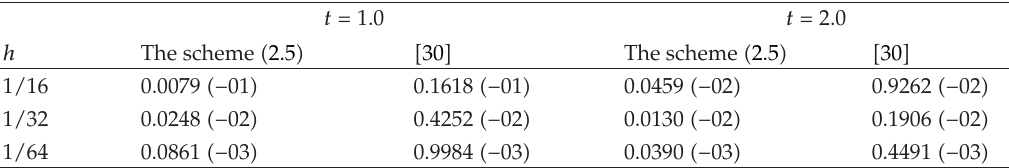
Table 12: RMS errors of scheme (cid:3) 2.5 (cid:4) and the scheme in (cid:6) 30 (cid:7) . t (cid:9) 1 .